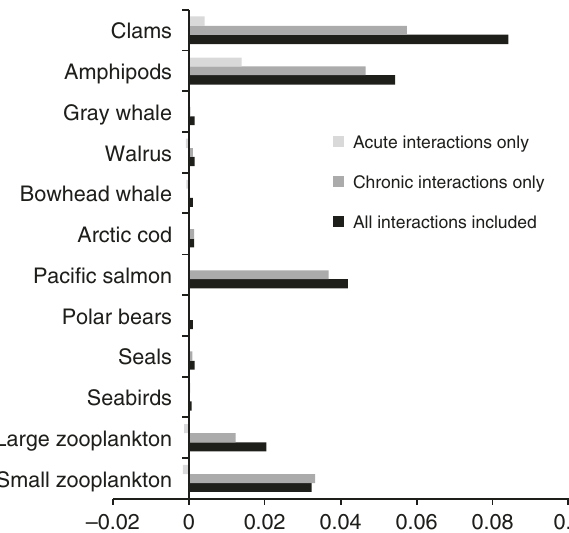
Fig. 3 The sensitivity of the variability of each node to interaction strength. This was calculated as the slope of the relationship between the variability in fi nal biomass of each node and changes in interaction strength, which varied from antagonistic to synergistic. Example data from which the slopes were calculated are shown in Supplementary Fig. 4. A separate set of simulations was run with only acute stressor interactions included, only chronic stressor interactions included, and all stressor interactions included. Positive numbers indicate that biomass variability increased with increasing interaction